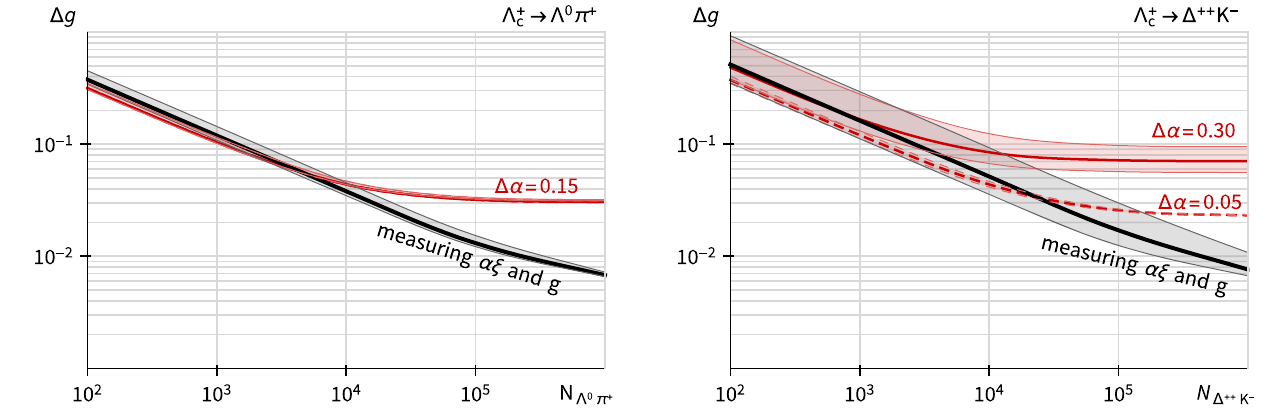
Fig. 7 Absolute error of g -factor as a function of reconstructed events number N j (left) for Λ + c → Λ 0 π + and (right) for Λ + c → Δ ++ K − decay channels. Red curves labeled with Δα value are obtained using the pre-measured values of α ξ rms x factor, black line corresponds to the